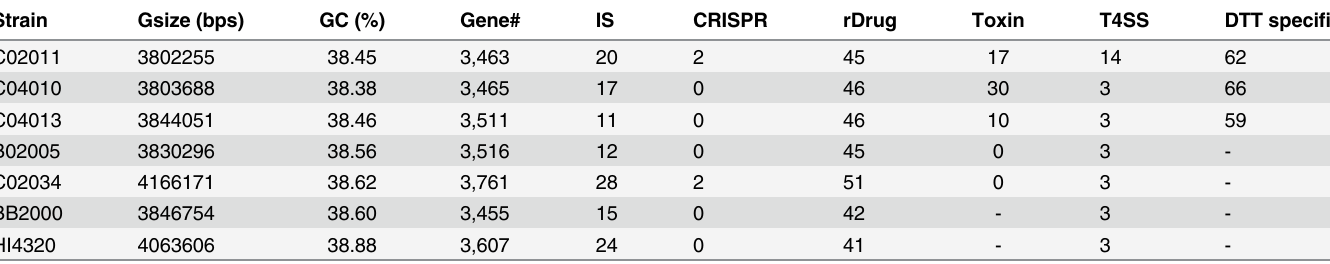
Table 3. Annotation summary of the seven P . mirabilis strains investigated in this study.